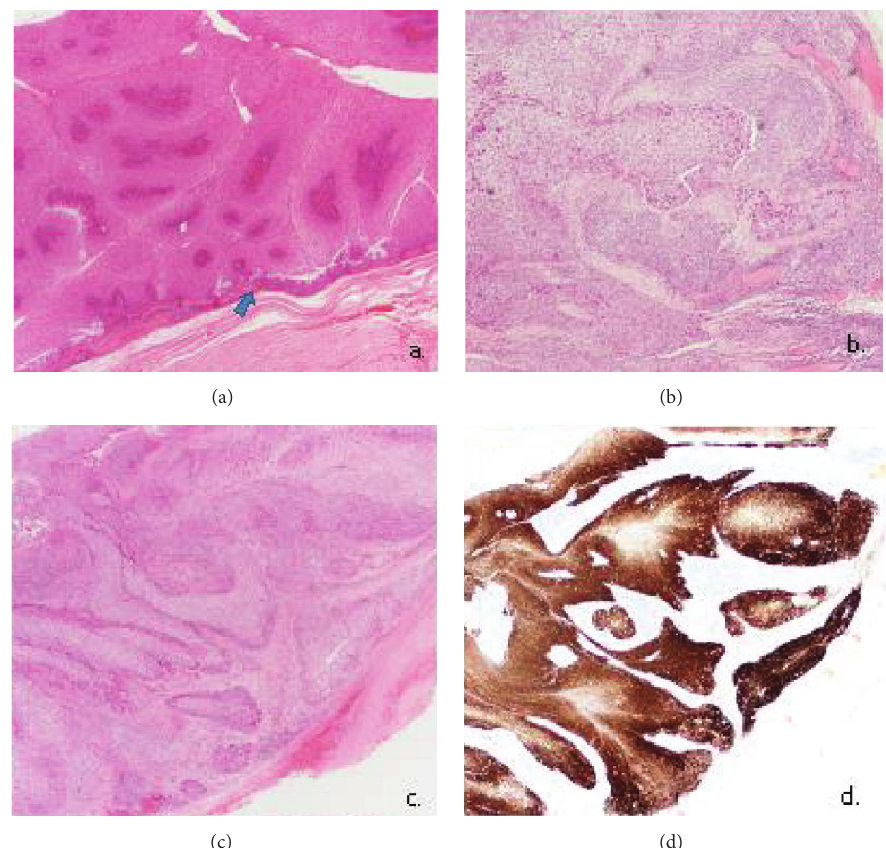
Figure 4: (a) Hyperplastic squamous epithelium growing endophytically. The inverted papilloma is seen to arise from nasolacrimal duct epithelium (arrow). Haematoxylin and Eosin, 20x. (b) Foci of atypia amounting to moderate dysplasia. No invasive malignancy is seen. Haematoxylin and Eosin, 40x. (c) Inverted pattern of growth. Haematoxylin and Eosin, 20x. (d) Immunohistochemistry for P16 showing block positivity. P16 IHC Syntech antibody,